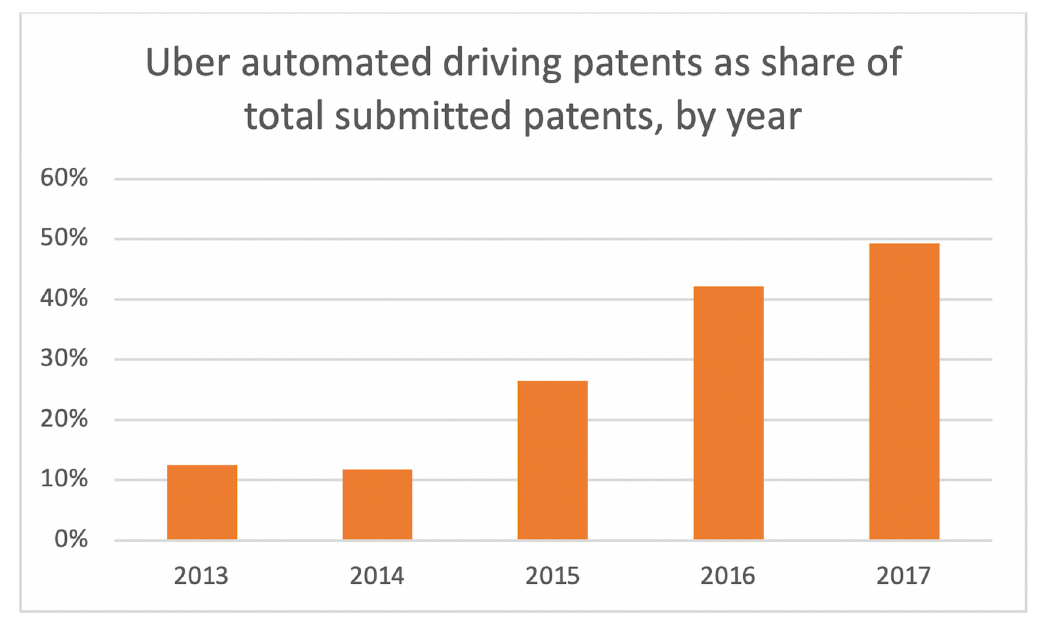
Figure 6: Automated delivery patents as share of total Uber patents, by year submitted. All 2013–2014 patents were